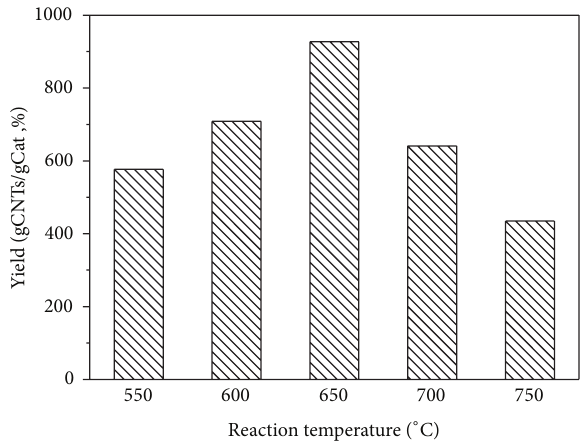
Figure 4: Yield of carbon on the catalyst Ni-Cu/MgO calcined at 500 ∘ C with different reaction temperatures.